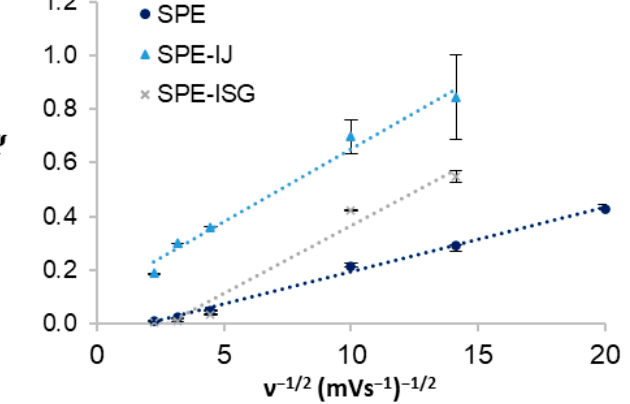
Figure 5. Plot of the kinetic parameter Ψ as a function of ν -½ for the three electrode types used.